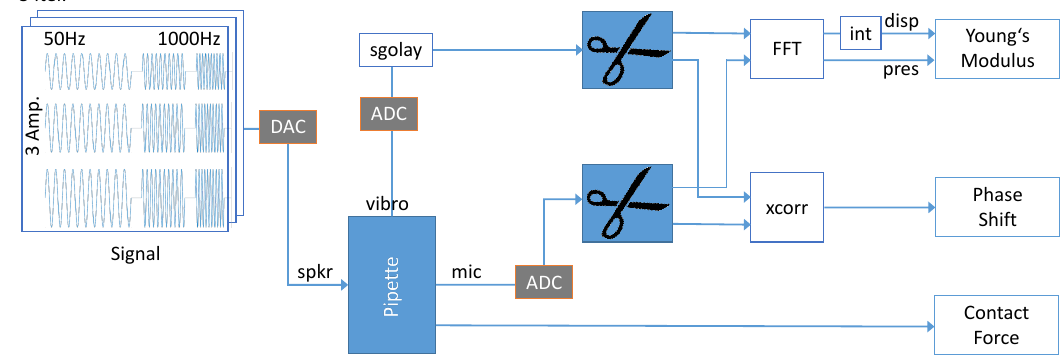
Figure 6. Algorithm architecture: The speaker (spkr) is driven at a harmonic signal with 10 periods per frequency, for 3 different amplitudes the signal is repeated in 3 iterations. The microphone (mic) measures the produced pressure difference and the vibrometer (vibro) registers the velocity of the tissue. After digitizing and filtering the signals, the signals are cut into sequences corresponding to the frequency. In that way, the Young’s modulus is calculated by determining the maximum displacement (disp) and pressure values (pres) by Fast Fourier Transforming these sequences. Additionally, the phase shift is evaluated by cross correlating those signals. The contact force is specified for each measurement with the load